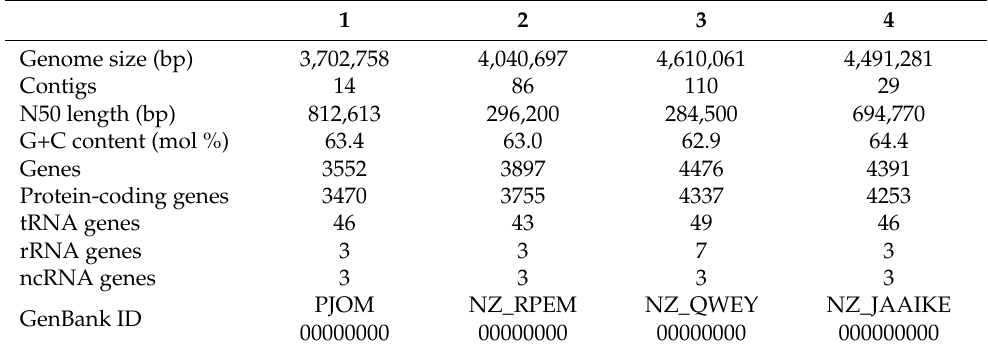
Table 2. Genome statistics of strain XJSP T and members of the genus Pseudotabrizicola .